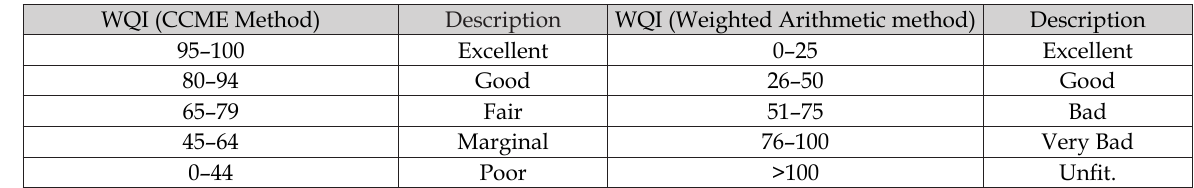
Table 1. Category of Water Quality.